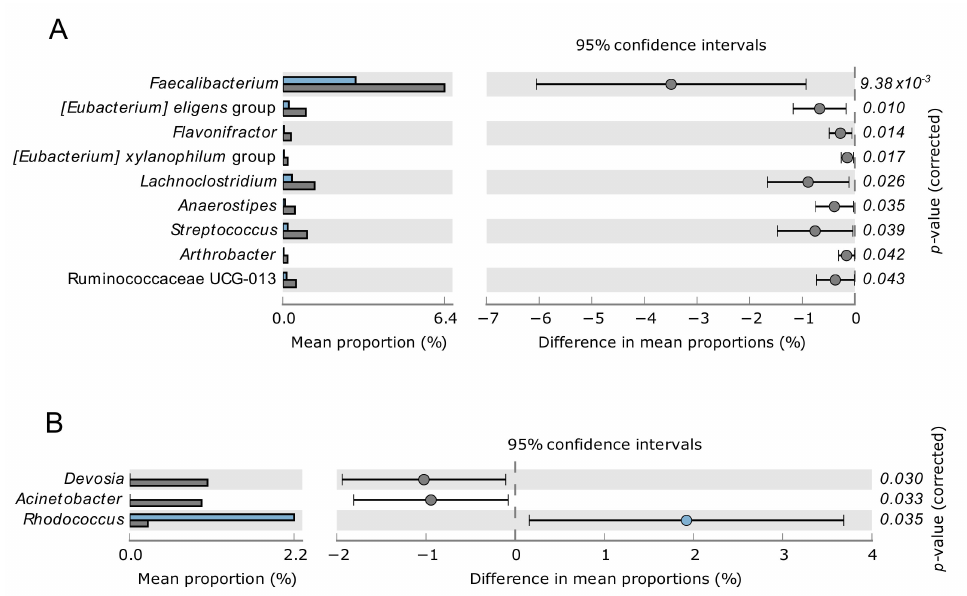
Figure 4. Relative changes of gut ( A ) or blood ( B ) bacterial taxa at the genus/family level in chronic kidney disease patients on peritoneal dialysis comparing patients with low all-cause mortality risk (Charlson Index scores of 2 or less, blue bars) with patients with moderate or severe all-cause mortality risk (Charlson Index scores of 3 or more, grey